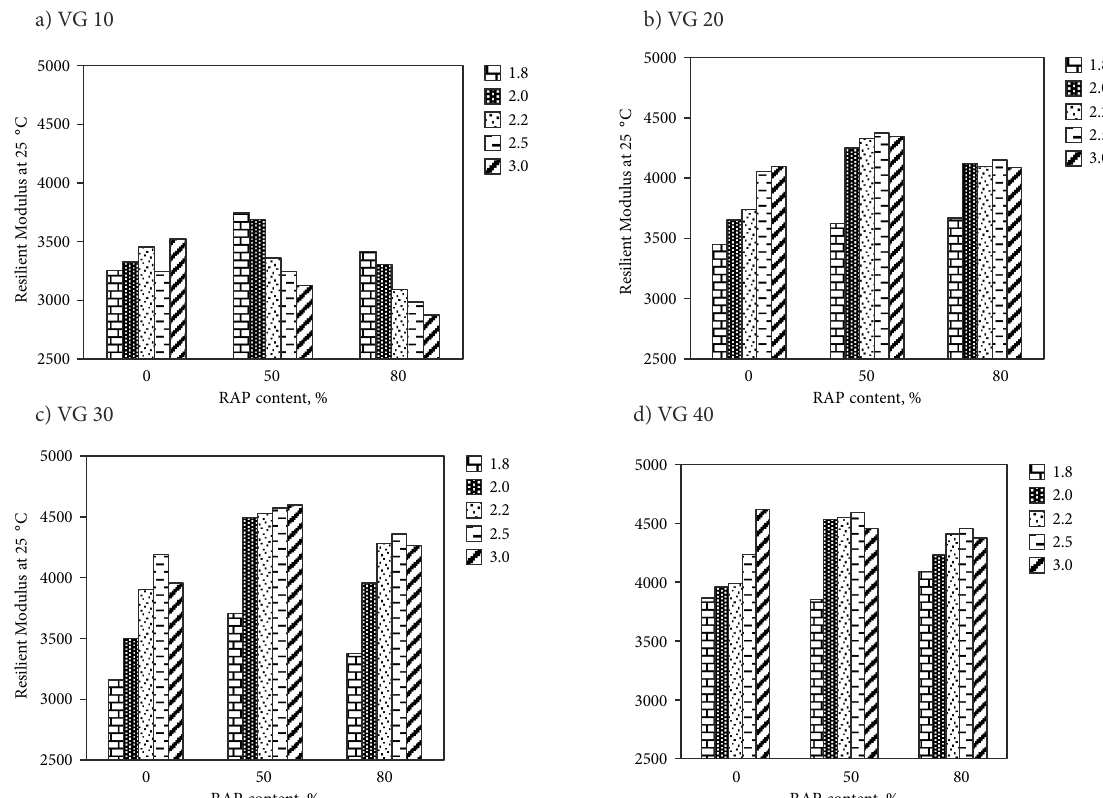
Figure 6. Variation of Resilient Modulus with Reclaimed Asphalt Pavement percentage and Foamed Bitumen Content at 25